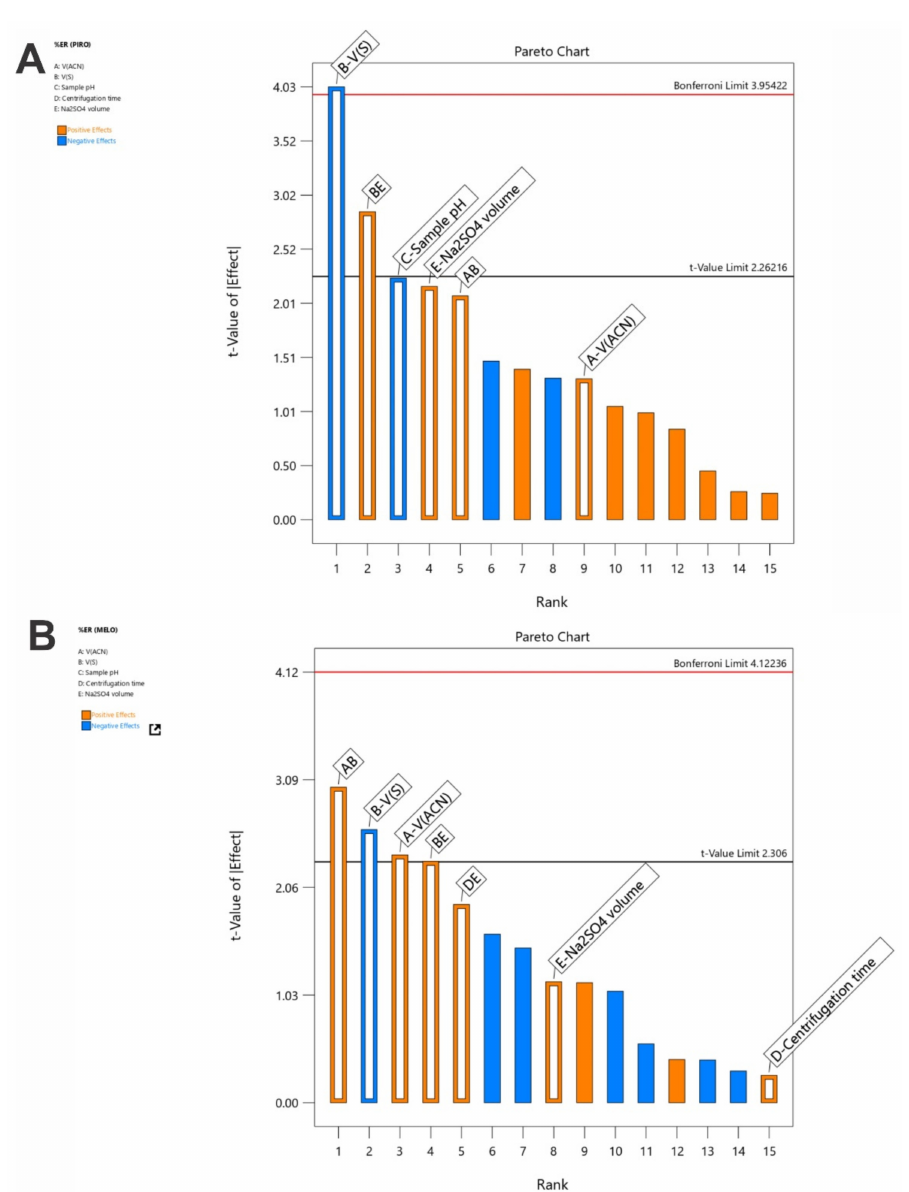
Figure 1. Pareto charts regarding the main effects of the SI-HLLME parameters for ( A ) piroxicam and ( B ) meloxicam using 2-level FFD. Orange and blue bars indicate the positive and negative effects,